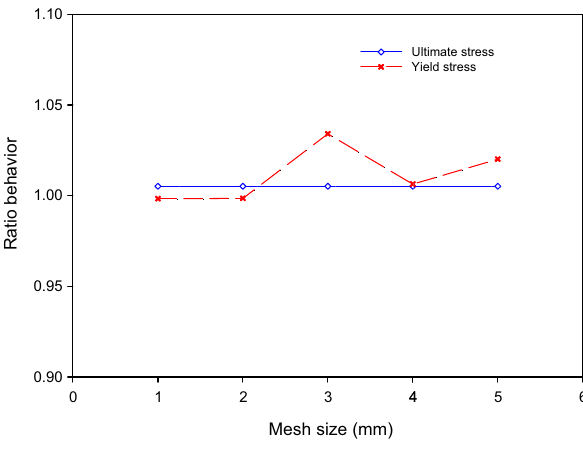
Figure 6: Ratio stress between experiment and fi nite element